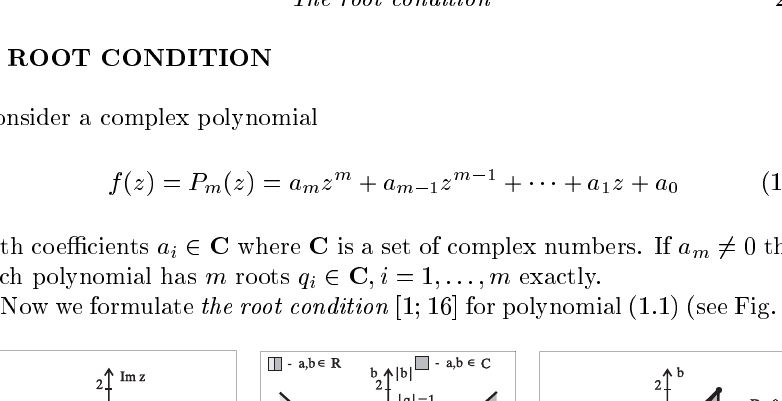
Figure(cid:0)(cid:1)Rootcondition(cid:1) Figure(cid:2)(cid:1)Criterionforlin(cid:14)